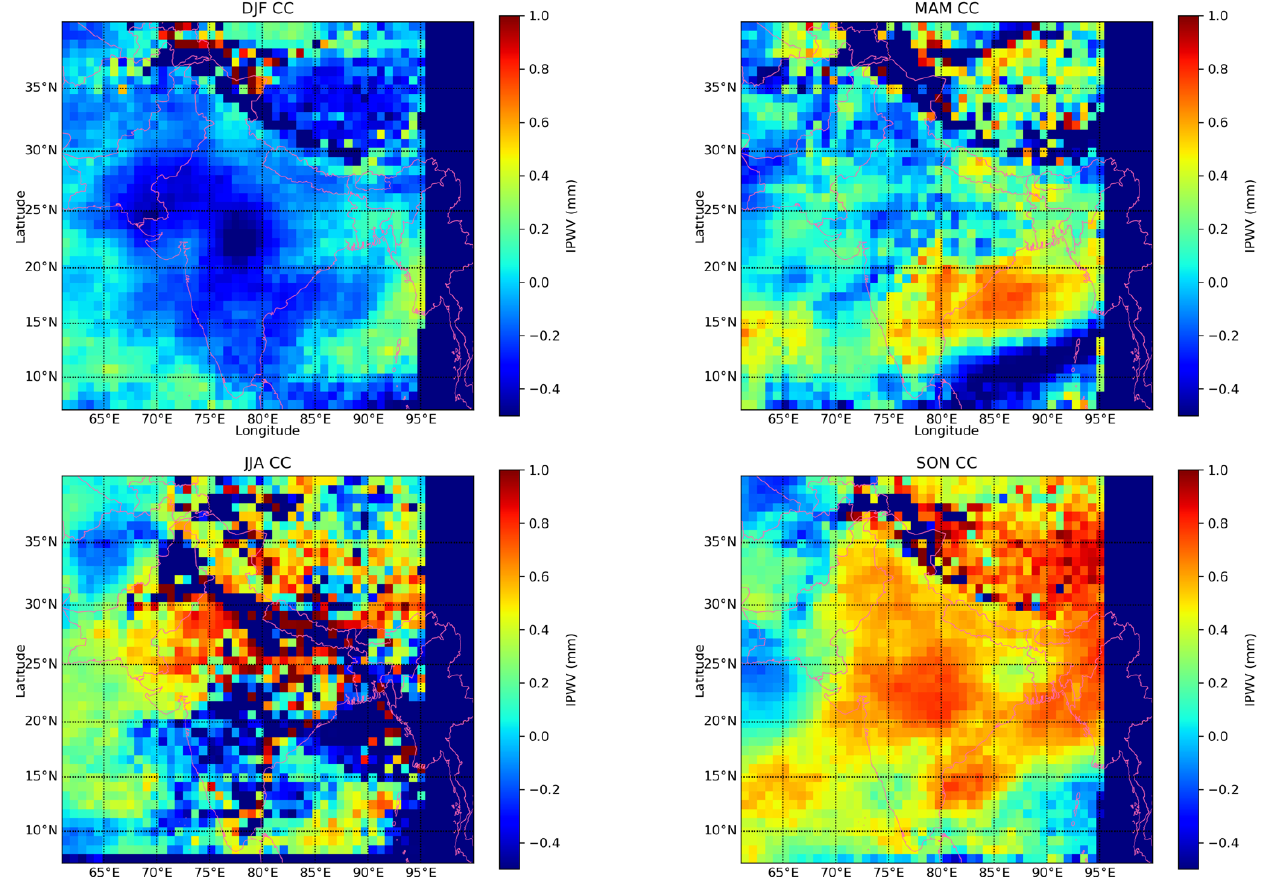
Figure 6. Seasonal correlation coefficient of CAMS and INSAT-3DR